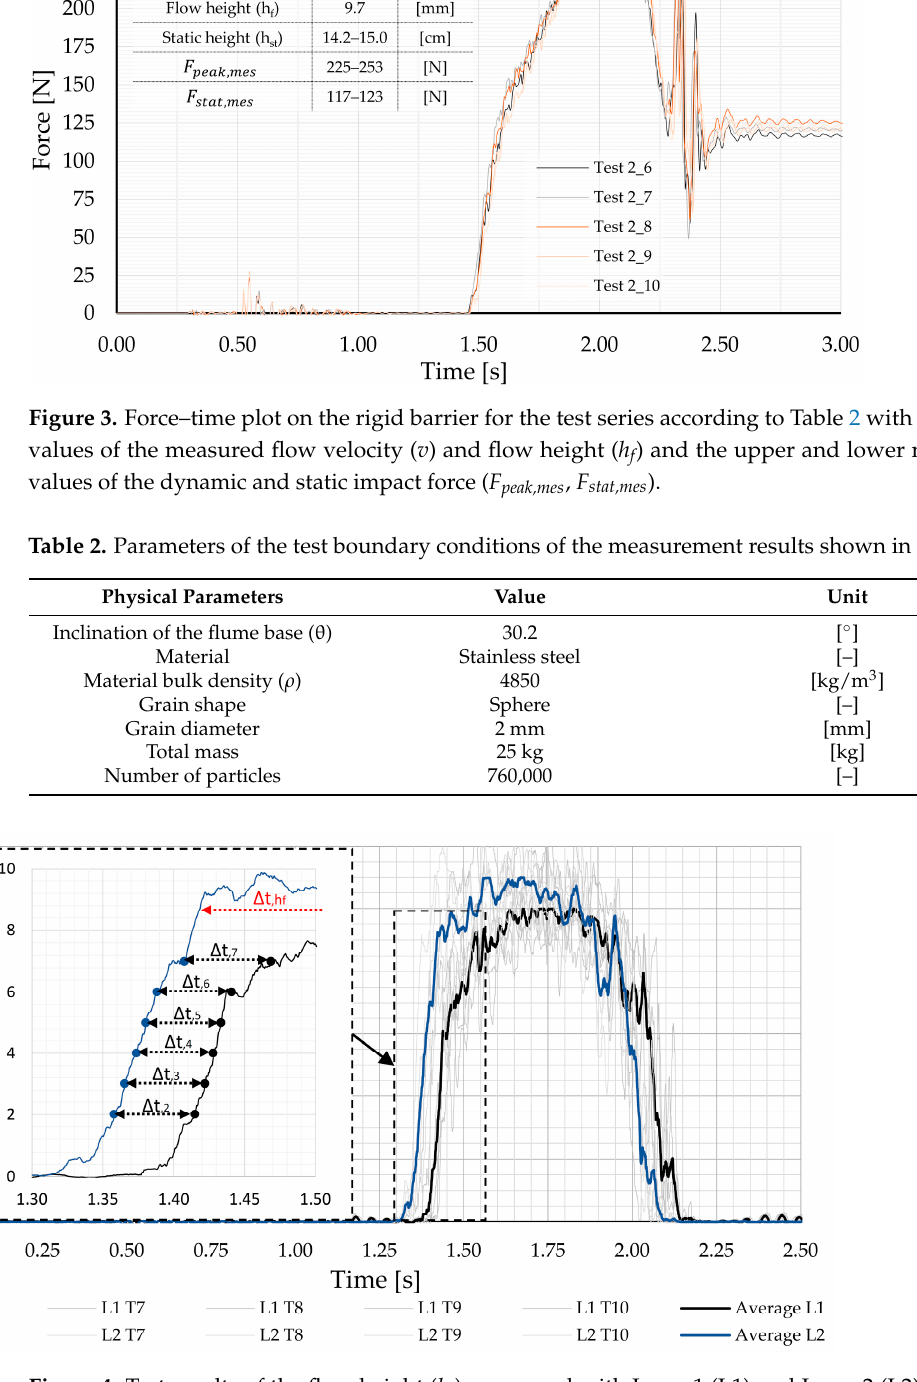
Figure 4. Test results of the flow height ( h f ), measured with Laser 1 (L1) and Laser 2 (L2) for Tests 6 (T6) to 10 (T10). The mean value of all test results is denoted by Average L1 and Average L2. ∆ t, 2 to ∆ t, 7 denotes the time difference at the same flow height between Average L1 and Average L2.